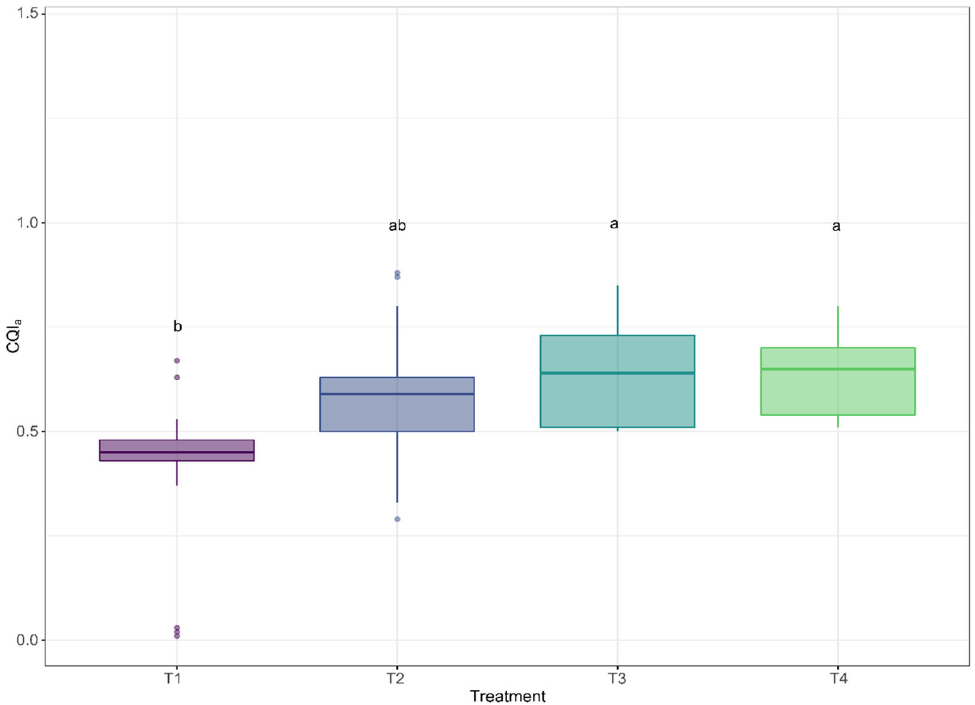
Figure 11. Friedman’s analysis of compost quality using the CQI a index. Different letters indicate significant differences according to Dunnett’s mean test with Bonferroni adjustment ( p ≤ 0.05 )